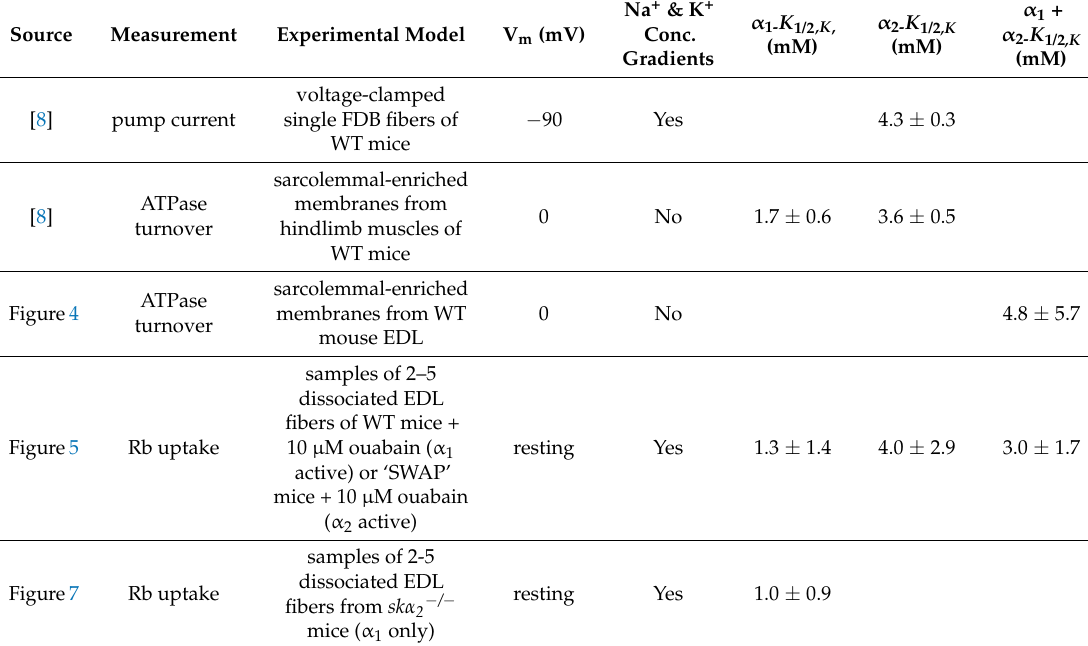
Table 4. K + affinity of Na,K-ATPase α 1 and α 2 isozymes in skeletal muscles determined using four experimental